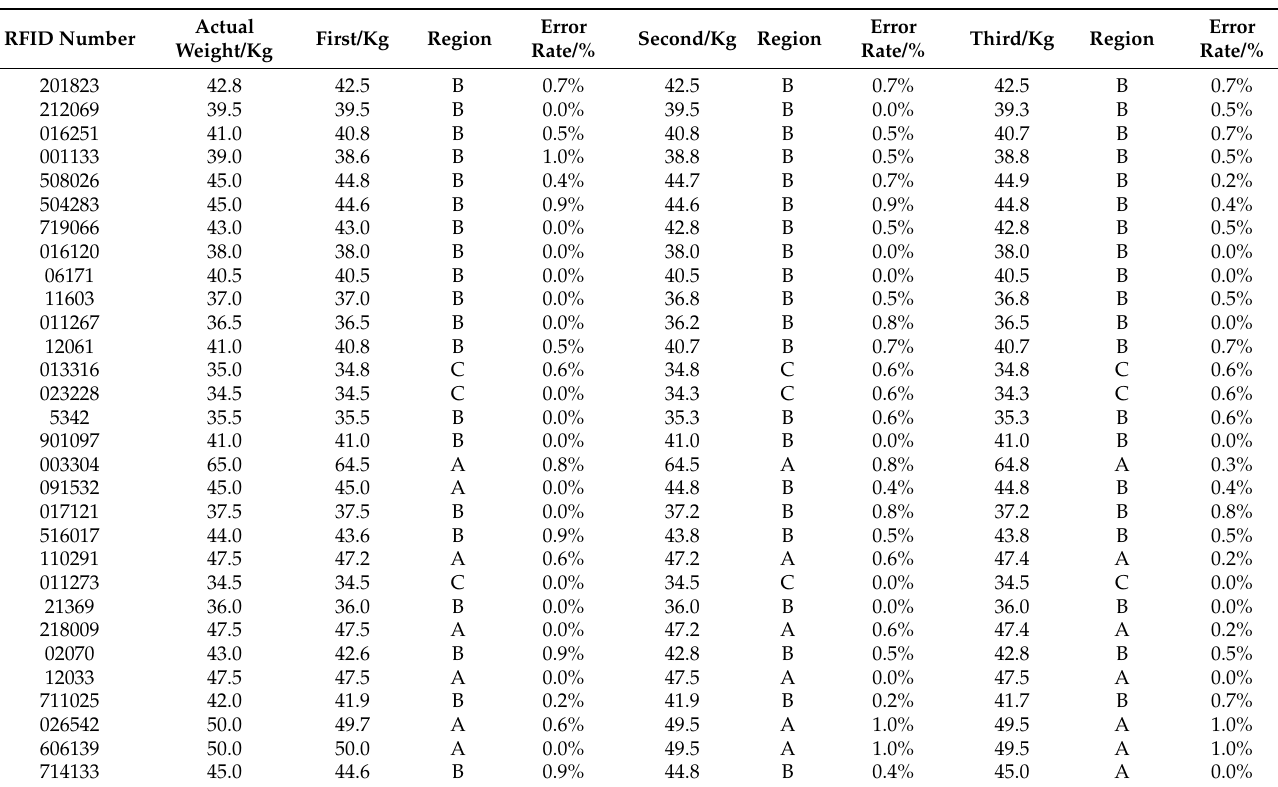
Table 1. Field experimental data for sheep.